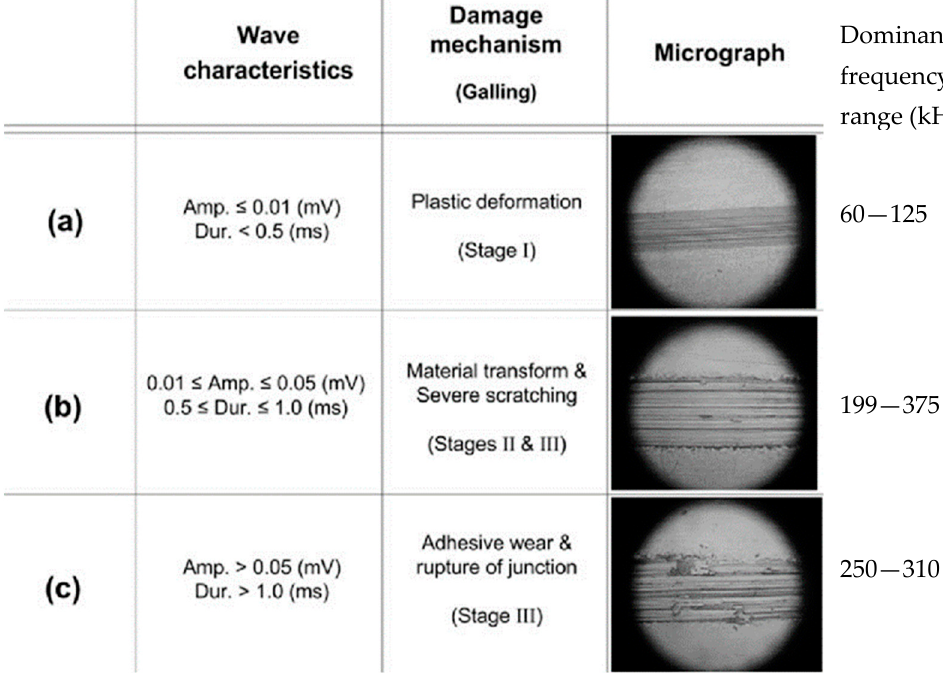
Figure 1. Wave characteristics for the three damage mechanisms and Dominant frequency ranges of the AE signals emitted during the three damage mechanisms. ( a ) stage 1 galling wear. ( b ) stage 2 and 3 galling wear. ( c ) stage 3 galling wear Reprinted/adapted with permission from [22].